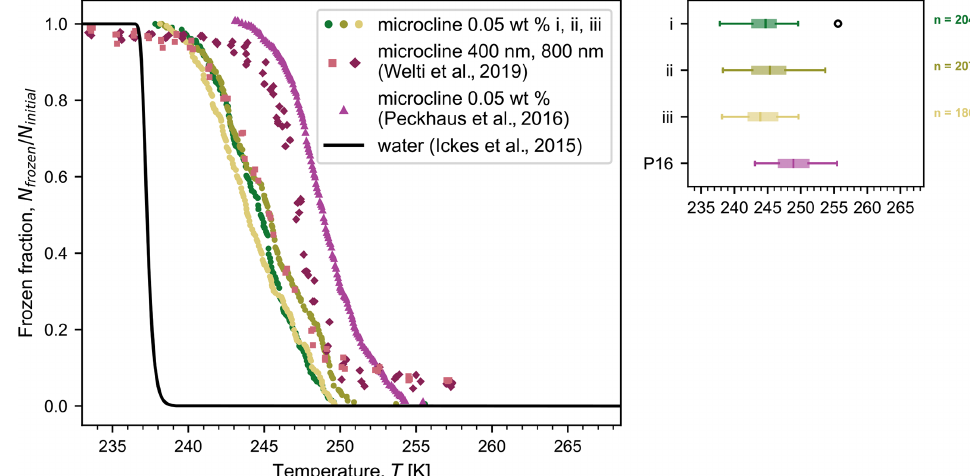
Figure 4. Frozen fraction of microcline droplets (0.05wt% in SA water with diameters as indicated in Table 2) as a function of temperature for three independent droplet populations (i, ii, and iii with n number of droplets) cooled at a rate of 1Kmin − 1 . We show frozen fractions reported by (i) Welti et al. (2019) obtained with the same microcline sample but using the Zurich Ice Nucleation Chamber (ZINC) for single particles size-selected to a mobility diameter of 400 or 800nm and (ii) Peckhaus et al. (2016) for a suspension of 0.05wt% microcline (digitized; P16 in the box plot). We emphasize that the total particle surface area in each case must be considered when comparing frozen fractions. The frozen fraction calculated using the parameterization from Ickes et al. (2015) for pure water droplets with a diameter of 75µm is also shown. On the right, a box plot compares the freezing temperatures of the three droplet populations; the centre line indicates the median freezing temperature, the box spans the interquartile range (between the 25th and 75th percentiles), the whiskers extend to the maximum and minimum temperatures, and outliers are shown by open circles. The temperature accuracy of our measurements is estimated to be ± 0 .